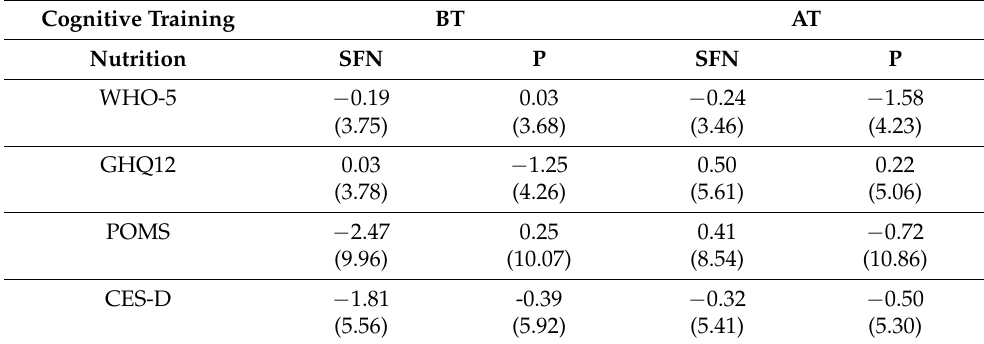
Table 4. Change scores of emotional states in all